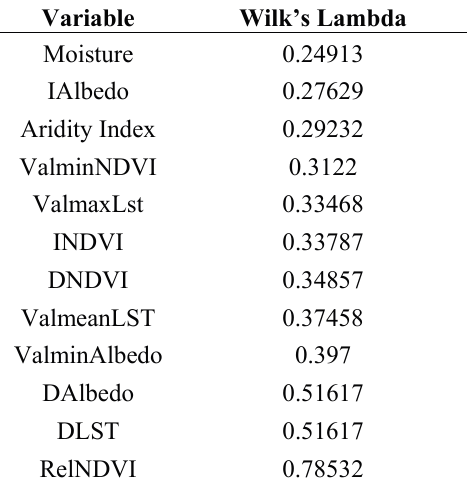
Table A. Wilk’s lambda results to identify the partial contribution of each variable in the discrimination of